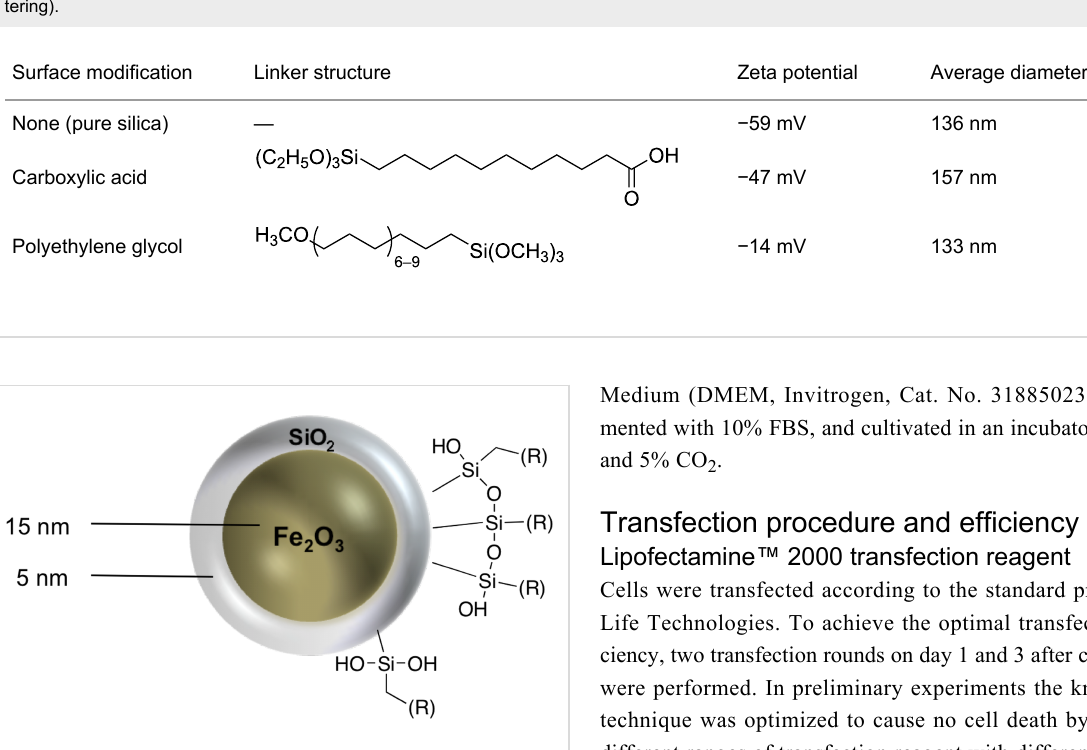
Figure 2: Schematic overview of SPION structure.